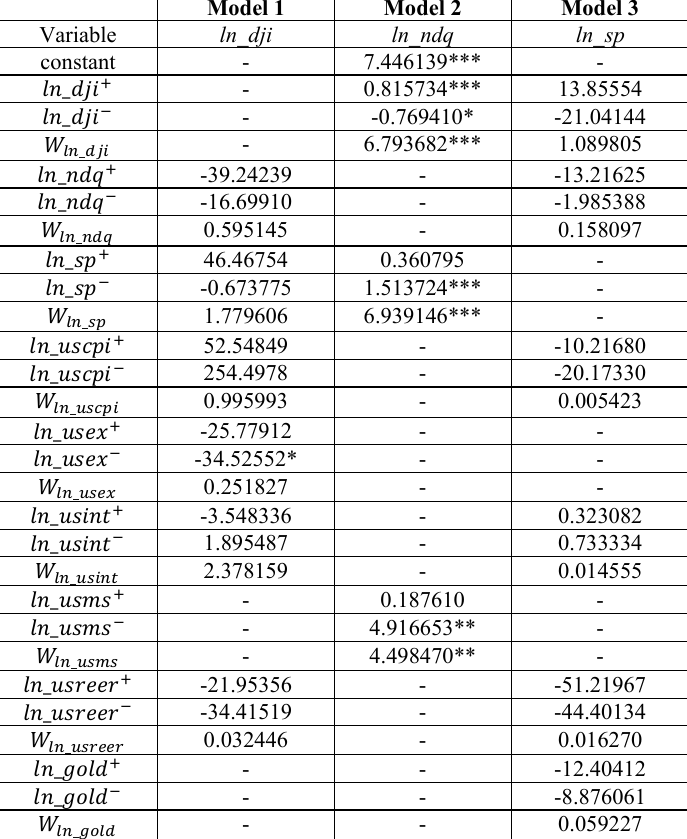
Table 1. All the variables form in Model 3 is having a symmetry effect on the S&P500 Index. Table 1. Estimation result of the long run